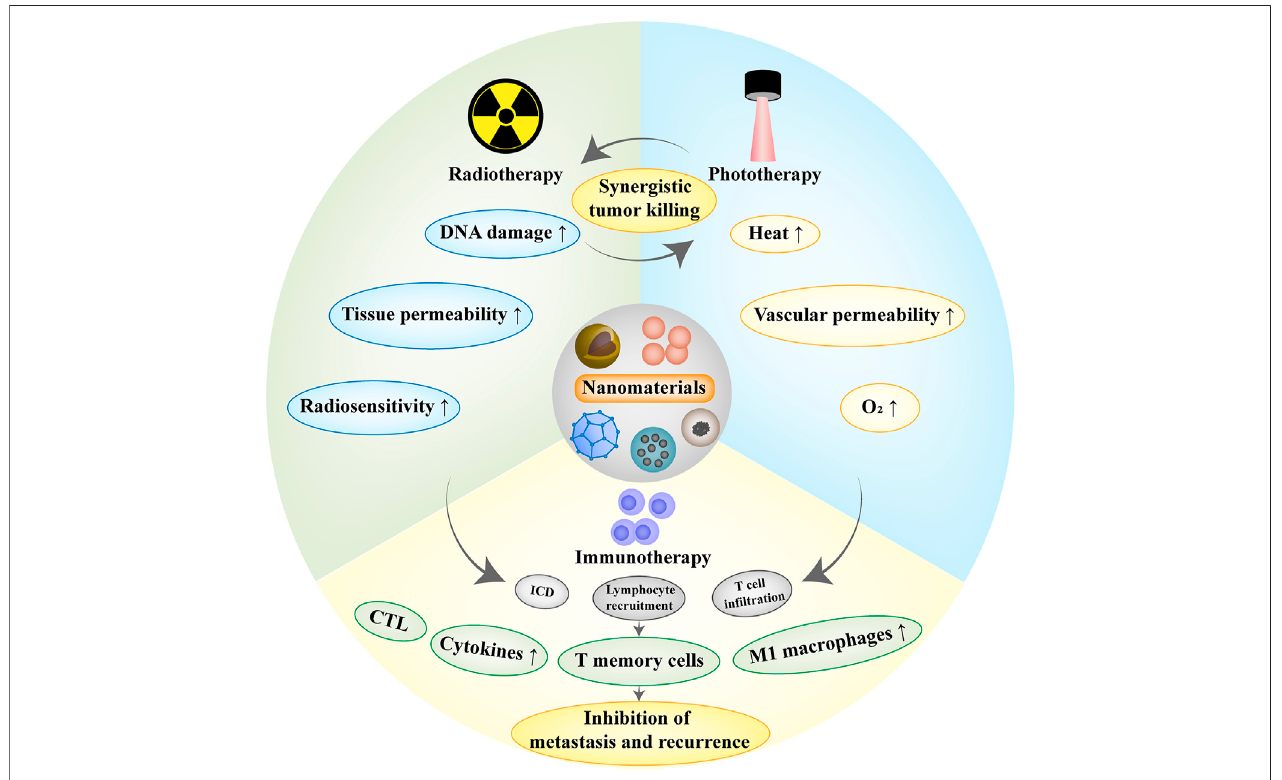
FIGURE3| Schematicdiagramoftumorcombinationtherapies.Radiotherapycanbreakthroughthelimitationofinsuf fi cienttissuepenetrationofphototherapy. In turn, photothermal therapy can improve vascular permeability and increase O 2 concentration, which facilitates the performance of radiotherapy. Radiotherapy/ phototherapy can induce immunogenic cell death (ICD), release tumor-associated antigens locally and increase T cell in fi ltration, and the combination with immunotherapy can effectively inhibit tumor metastasis and recurrence.